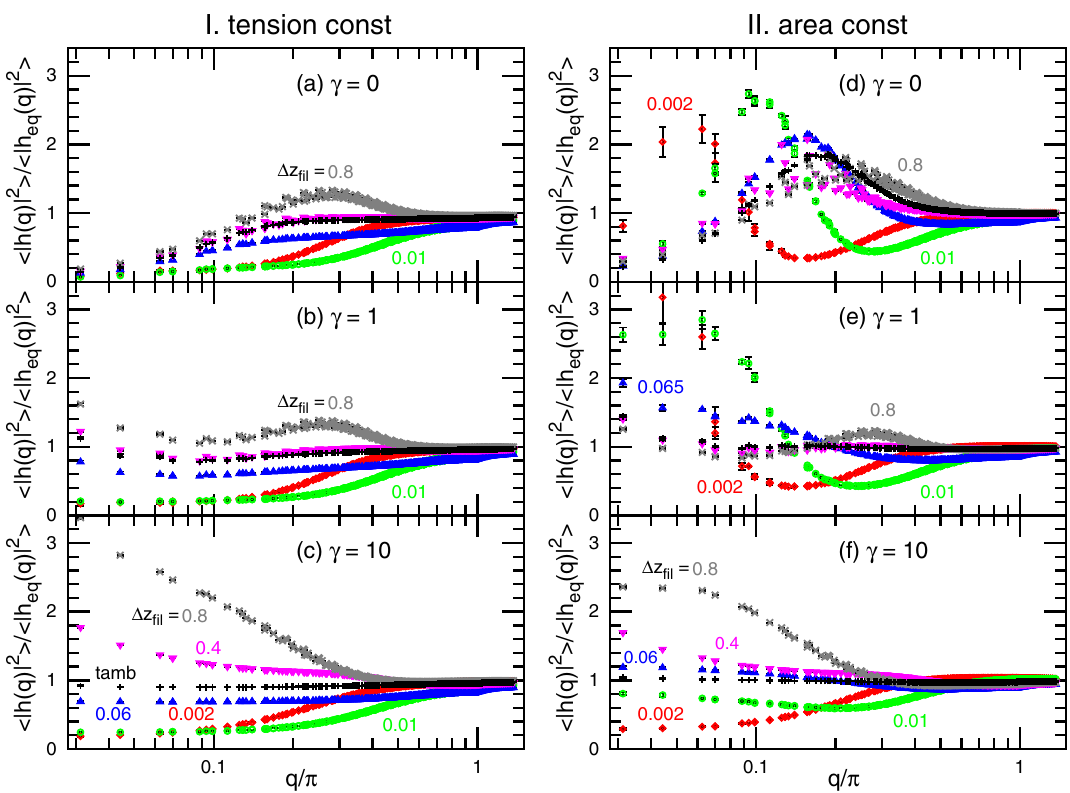
2 2 / h ( q ) h eq ( q ) 0.002 , 0.01, for (cid:31) z fil �| | � �| | � = 0 ; = 0.06 or 0.065, where the distance =